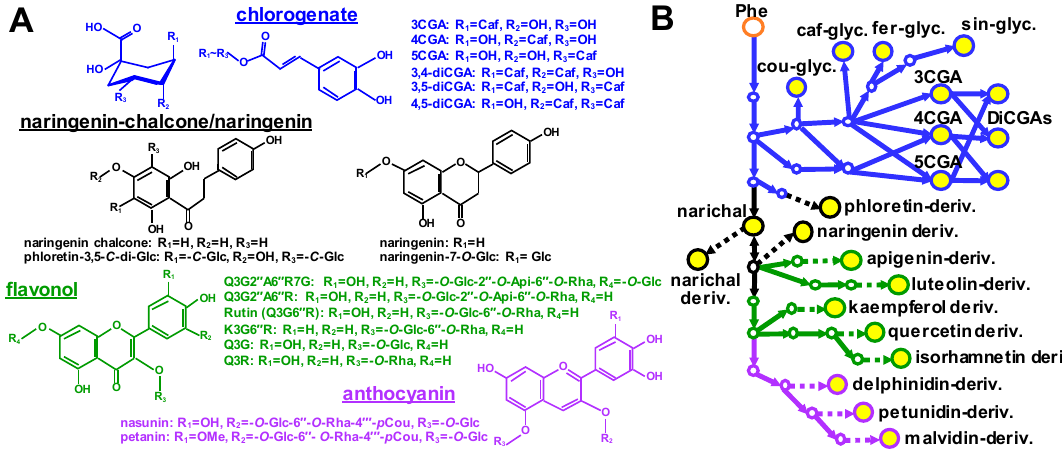
Figure 1. Major polyphenolic compounds reported in mature fruit of solanaceous crops. ( A ) chemical structure of major polyphenolic specialized metabolites found in solanaceous crops. Chlorogenates (CGAs), naringenins, and flavonols are shown. ( B ) the biosynthetic framework of polyphenolic compounds in solanaceous crops. Biosynthetic pathways were constructed by an online database search and literature review of major polyphenolic compounds in solanaceous crops. Color: Blue, hydroxycinnamates; black, stilbenoids/flavanones and chalcones; purple, anthocyanins; and green, flavonols/flavones; orange, amino acid. Yellow color inside of circle indicates major accumulation form in the plant. Abbreviations: Phe, phenylalanine; cou, coumaroyl; caf, caffeoyl; fer, feruloyl; sin, sinapoyl; glyc, glycoside; deriv, derivative. K, kaempferol; Q, quercetin; Narichal, naringenin chalcone; CGA, chlorogenate; DiCGA, dica ff eoyl-chlorogenate; Glc, glucose; Rha, rhamnose; Api, apiose; and hex, hexose.